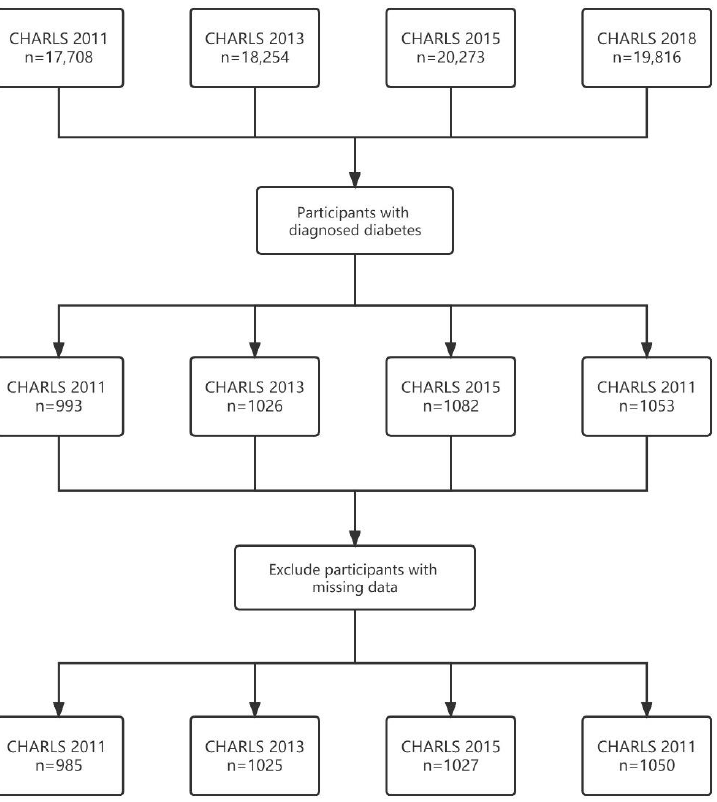
Figure 1. Sample screening of diabetic participants in CHARLS 2011, 2013, 2015 and 2018 for the present study.